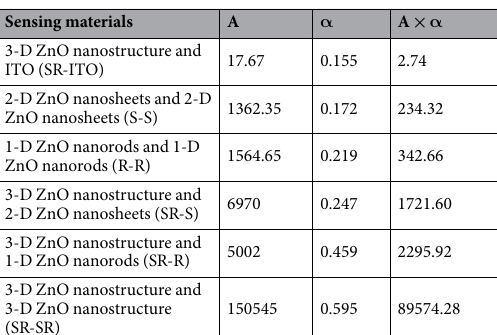
Sensing materials